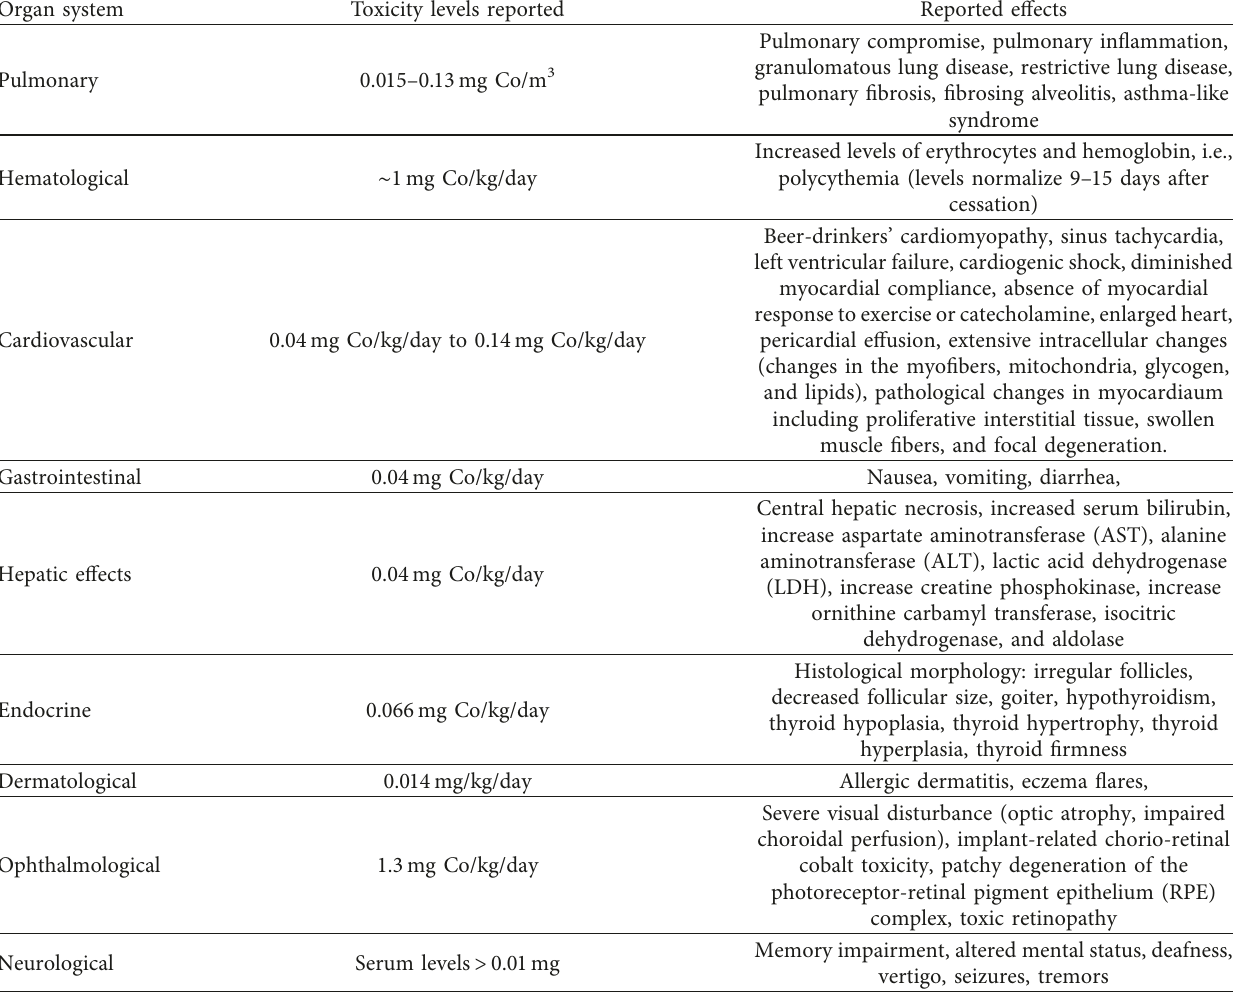
Table 1: Summary of effects of cobalt exposure